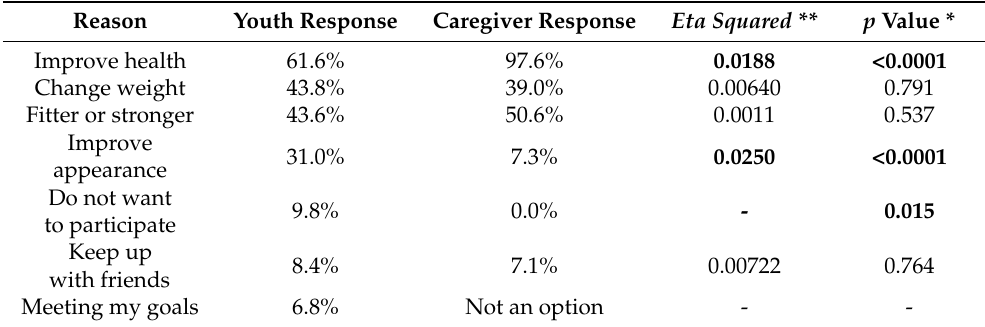
Table 4. Reasons for participation in PWMP (ranked either most or 2nd most